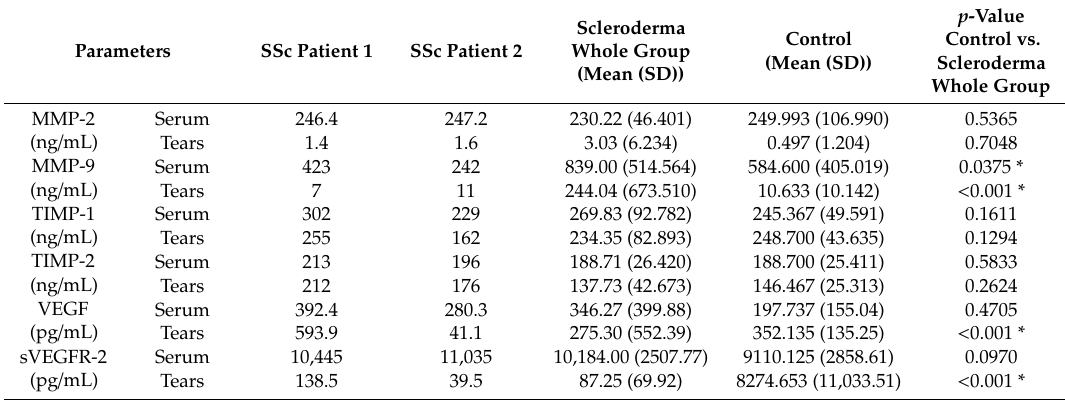
Table 1. Results of laboratory parameters for two patients with ischemic retinopathy (SSc 1 and 2) and comparison of parameters between all SSc patients and controls.